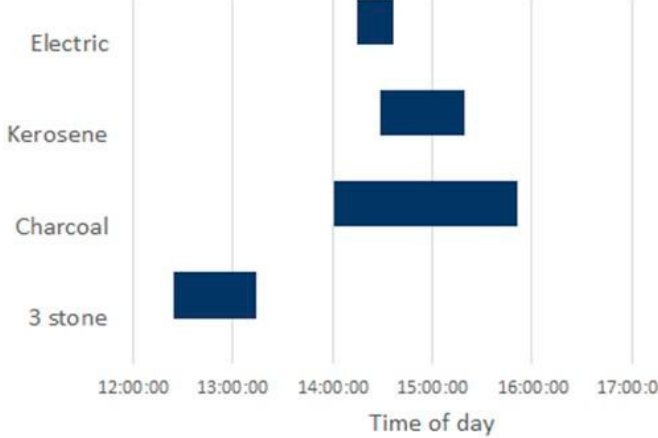
Figure 10. Time of day and duration of use